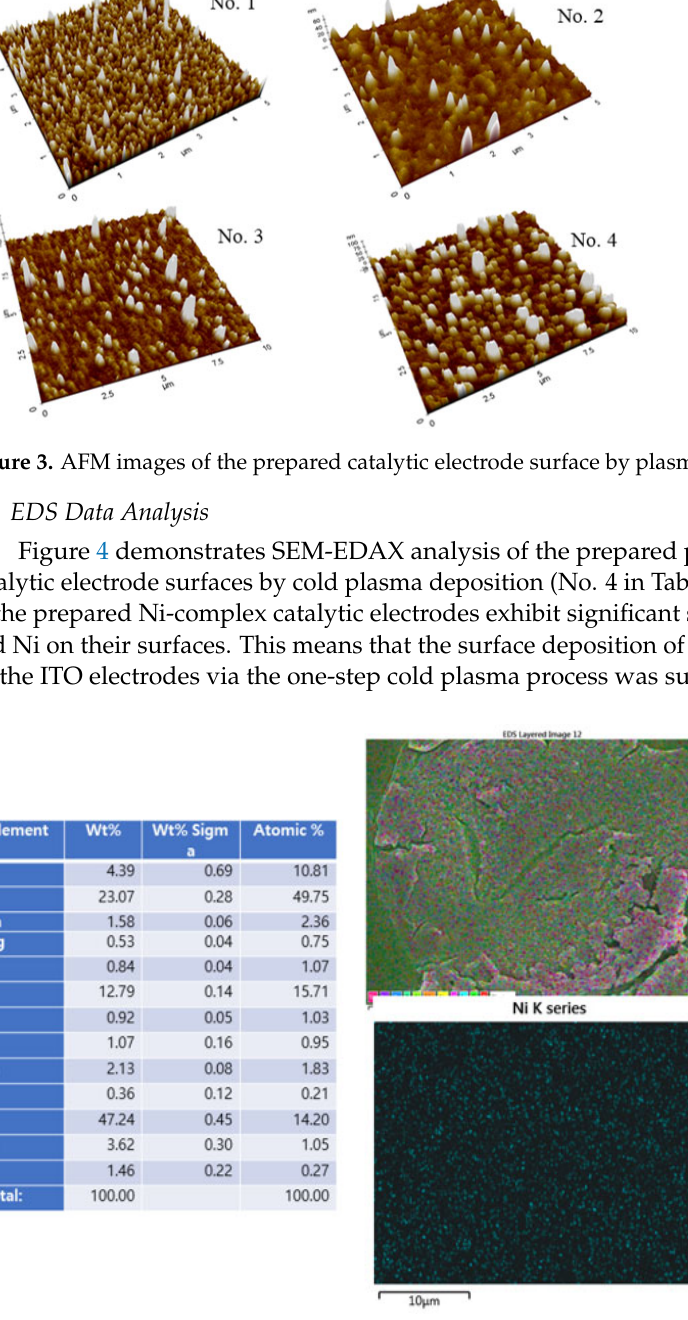
Figure 4. EDAX analysis of the prepared Ni-modified catalytic electrode surface by plasma deposition (No. 4 in Table 1).